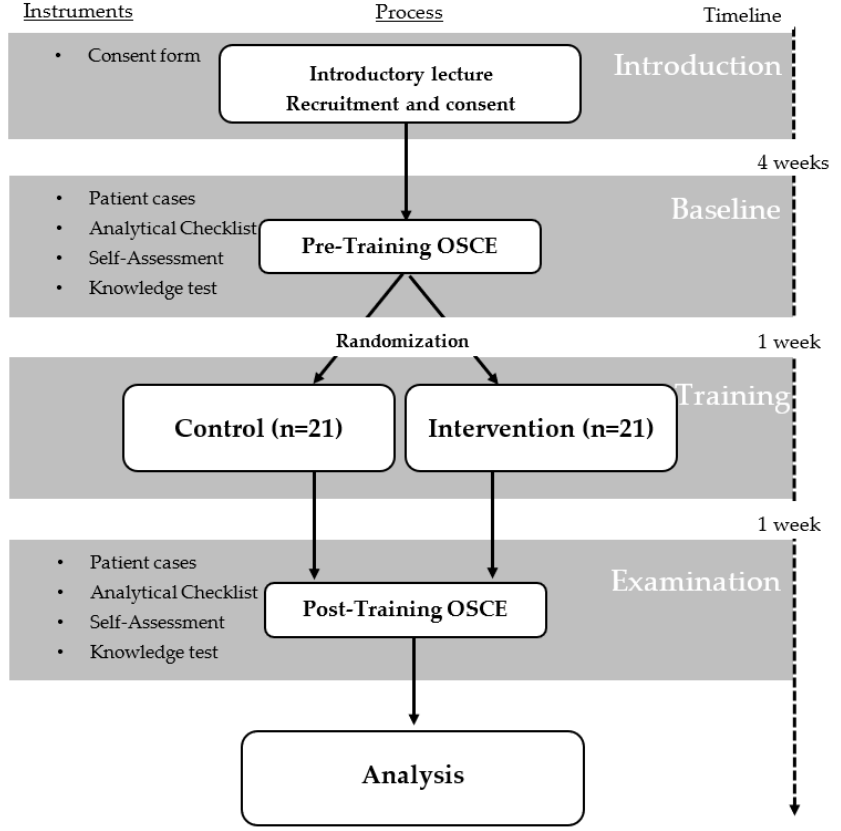
Figure 3. Flow Chart of the randomized controlled study. OSCE = objective structured clinical Ex- amination.